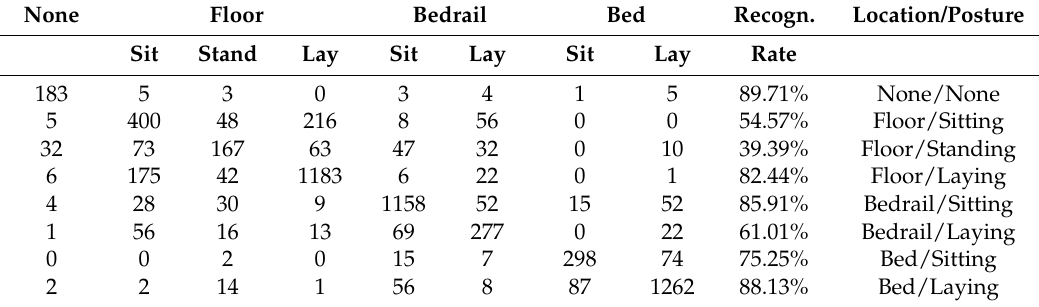
Table 8. Confusion matrix of location and posture classification during a J48 single classification run. None